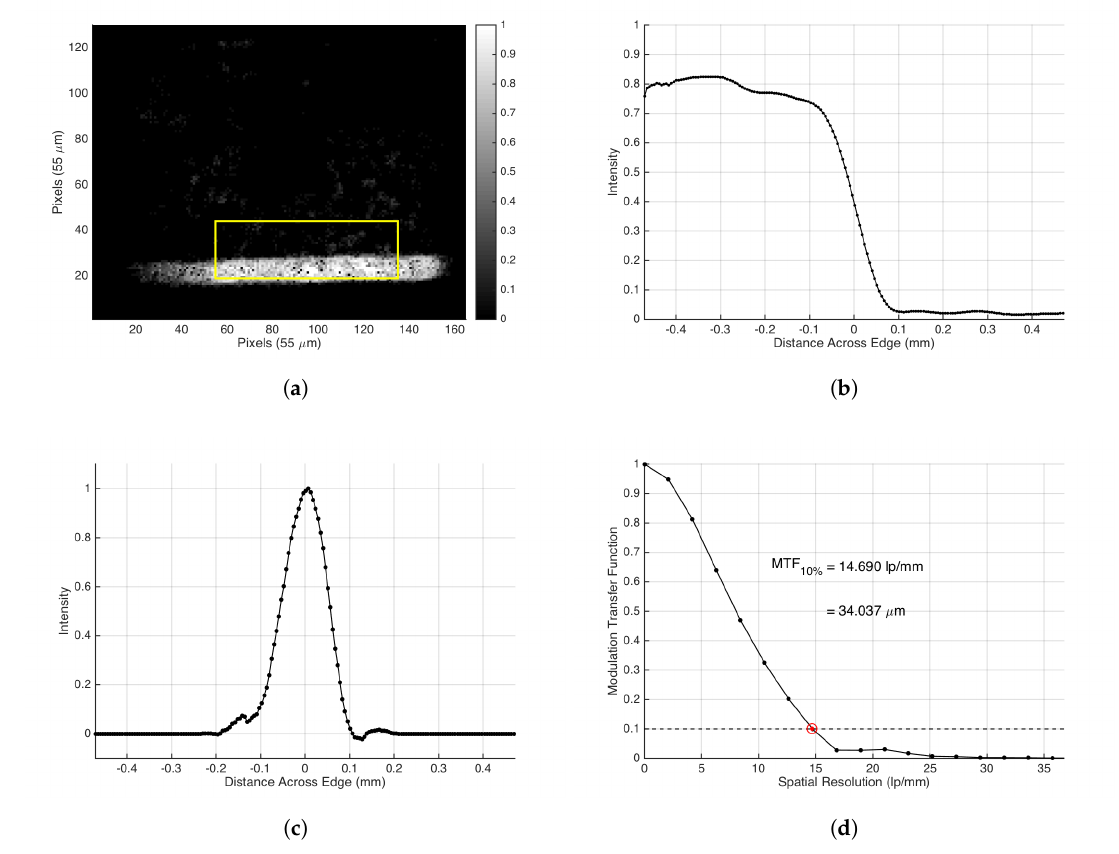
Figure 10. Modulation transfer function method to calculate edge resolution. ( a ) 750 µ m slit with ROI overlay; ( b ) slit edge spread function; ( c ) slit line spread function; ( d ) slit modulation transfer